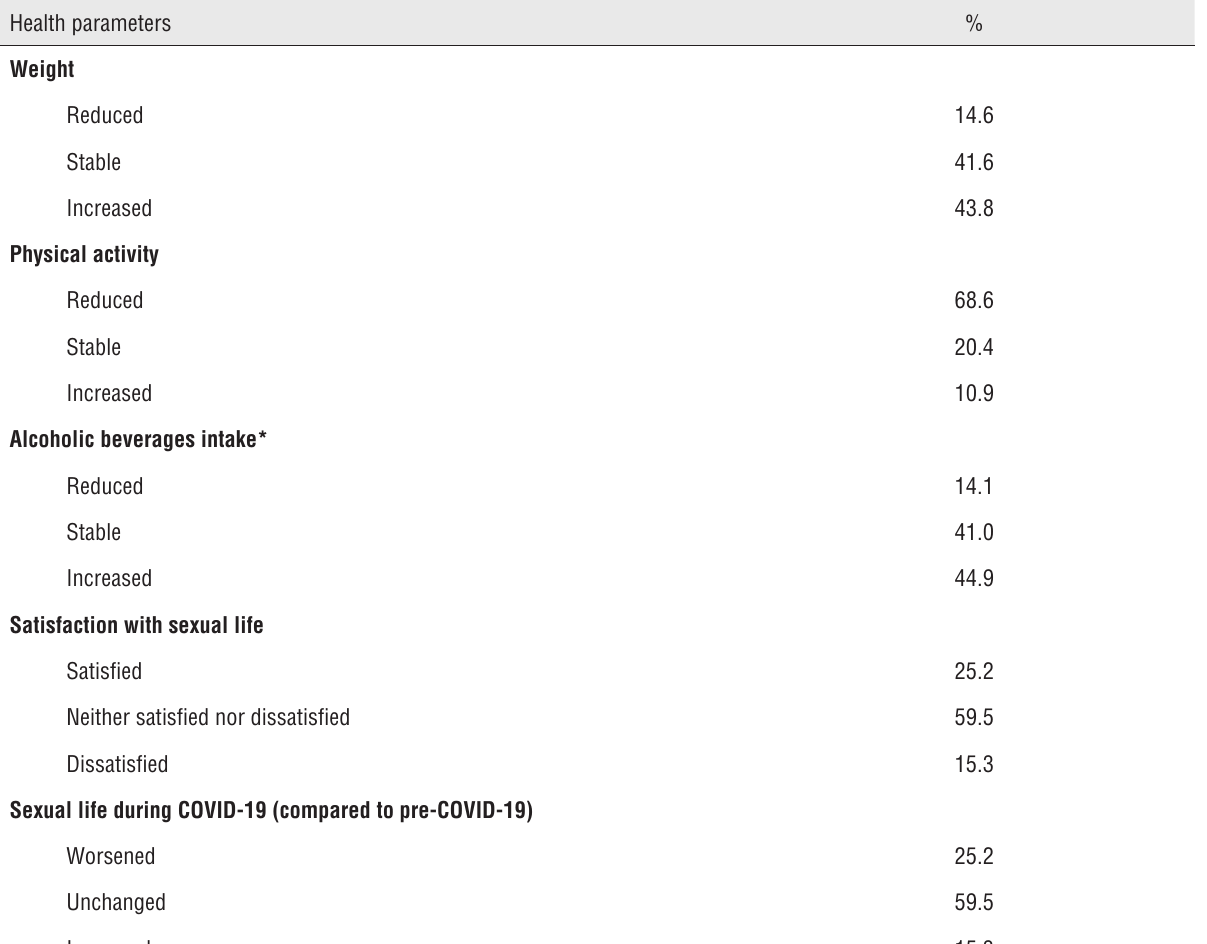
Table 3 - Health parameters during